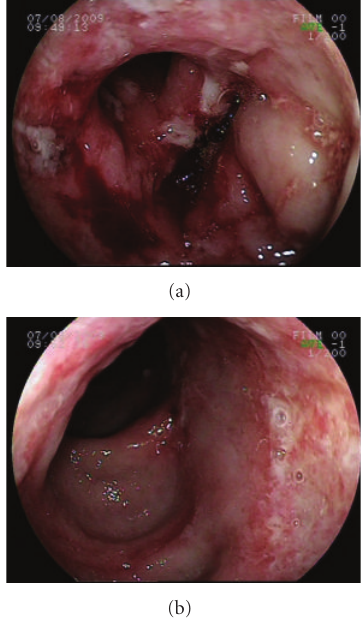
Figure 2: Colonoscopy showing (a) Intense inflammatory stenotic ulcer and (b) giant exudative colonic ulcer.